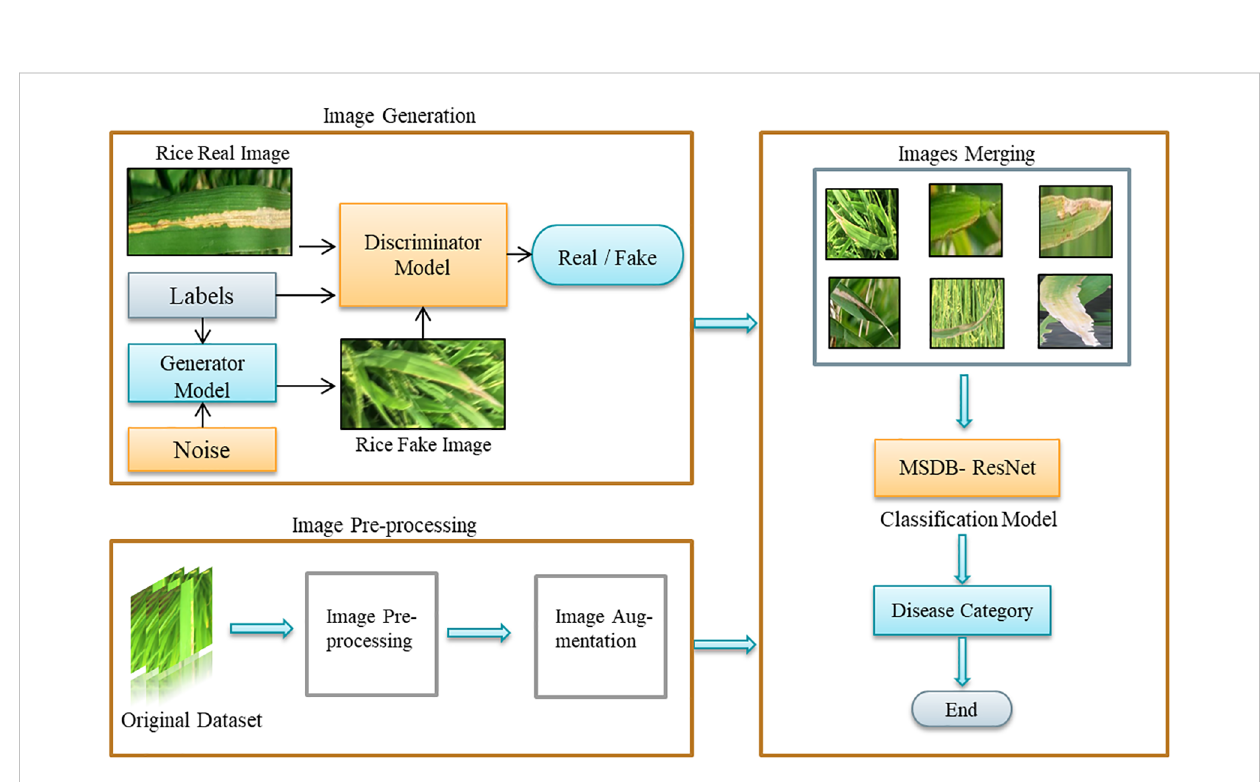
FIGURE 8 Overall process of rice disease